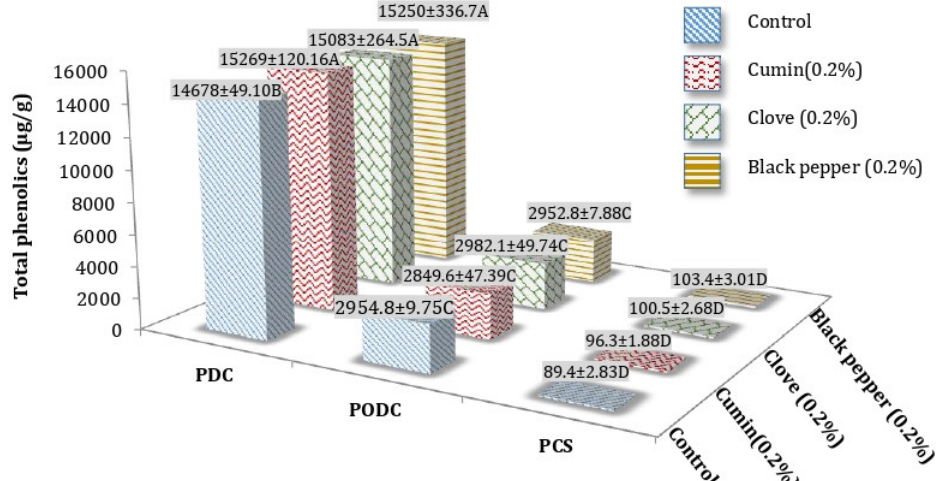
Figure 3. Mean values for Total phenolic content (TPC) ( µ g/g gallic acid equivalent) of processed cheddar cheese (PCS), orally digested (PODC), and duodenal digested cheddar cheese (PDC) made from buffalo milk after ripening. A–D means followed by the same letter for the same parameter are not significantly different ( p < 0.05).